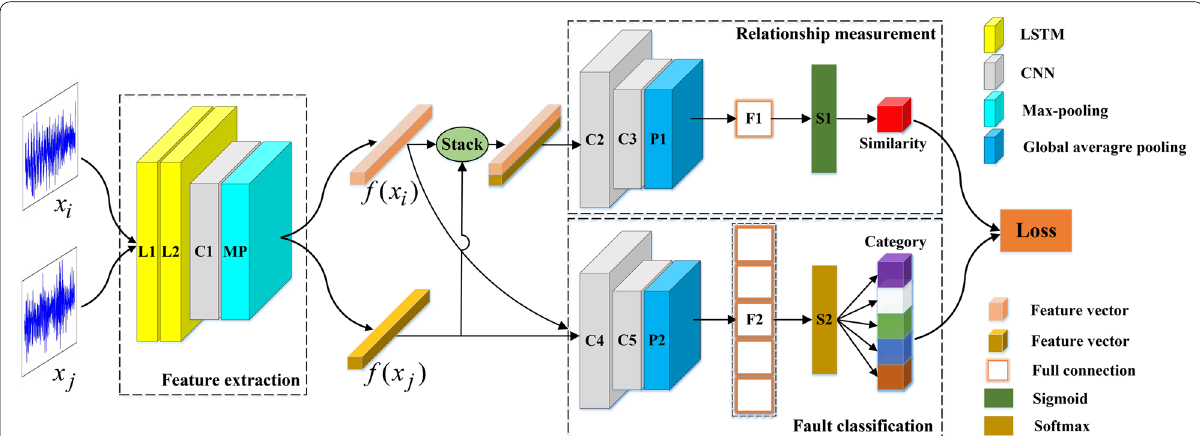
Fig. 2 Structure diagram of ISNN model.The proposed ISNN bearing fault diagnosis model included three networks: feature extraction, relationship measurement, and fault